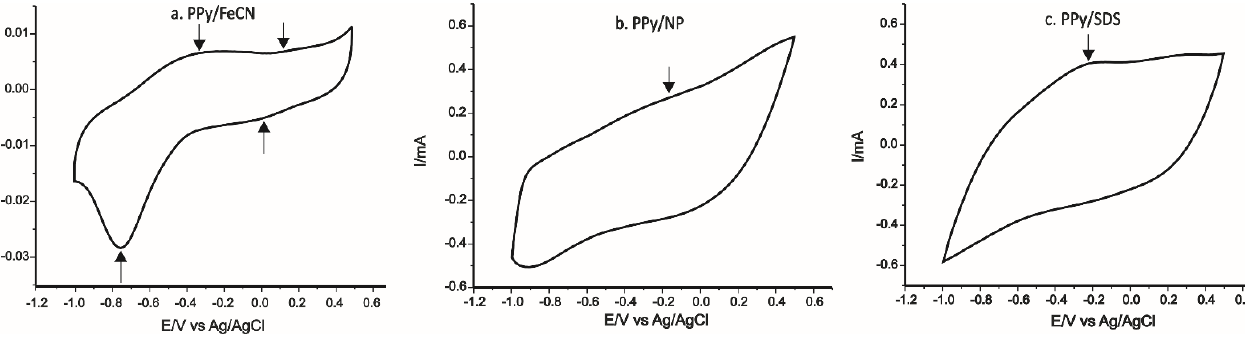
Figure 8. Stable response of polypyrrole based sensors immersed in 0.1 M KCl solution at 0.1 V × s − 1 : ( a ) PPy /FeCN-SPCE; ( b ) PPy/NP-SPCE, and ( c ) PPy/SDS-SPCE.